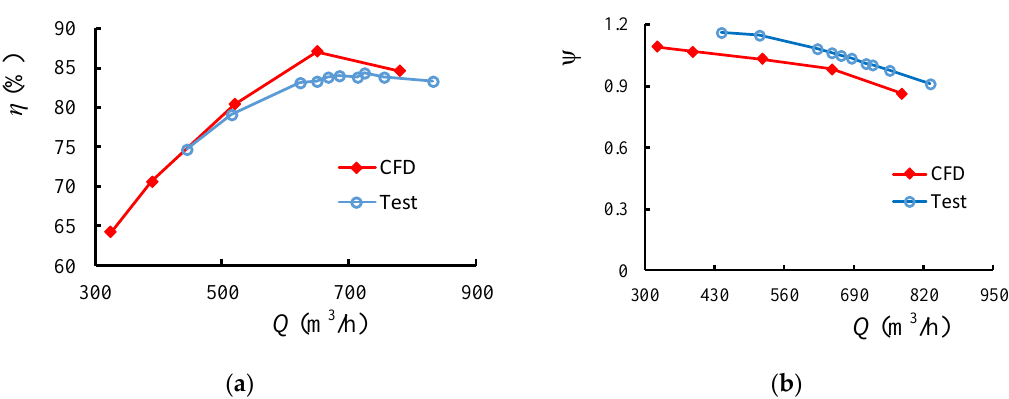
Figure 7. Comparison of the external characteristic curve between the experiment and the numerical simulation. ( a ) Efficiency curve; ( b ) head coefficient.